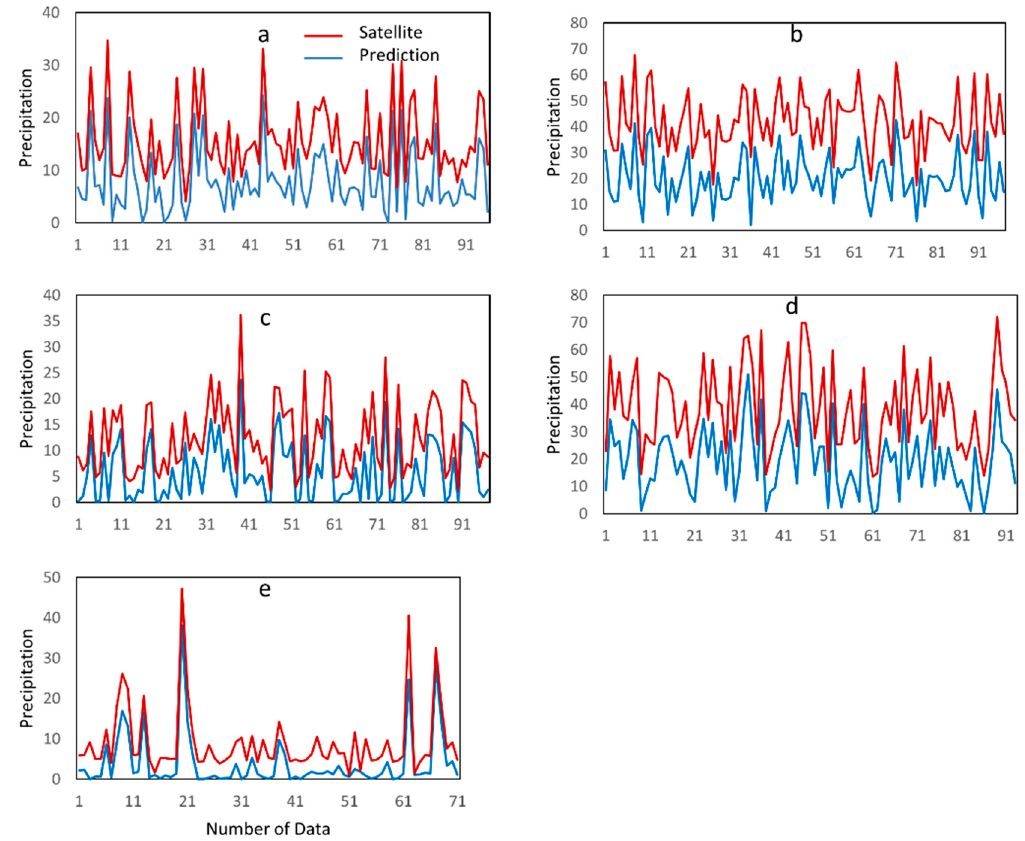
Figure 6. PSO predicted precipitation of the five events over Northeast Austria for ( a ) 17 April 2015, ( b ) 23 May 2015, ( c ) 03 September 2015, ( d ) 25 September 2015, and ( e ) 07 October 2015.